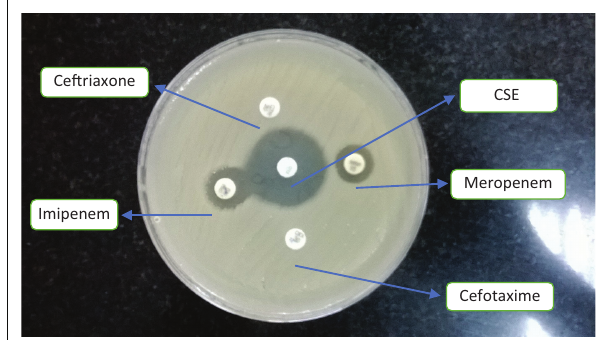
FIGURE 1: Zone of inhibition around the ceftriaxone-sulbactam-disodium edetate disc, Delhi, India, February 2017 to June